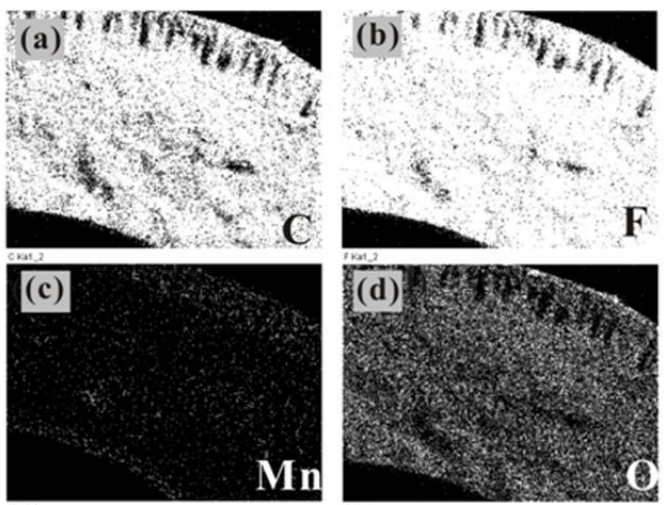
Figure 4. Mapping image of the Mn 3 O 4 /PTFE HFM of: ( a ) C element; ( b ) F element; ( c ) Mn element; ( d ) O element.